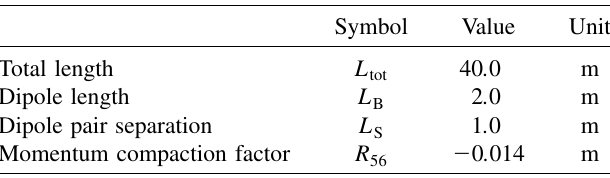
TABLE I. Parameters common to all bunch compressor chi- canes compared in this paper.